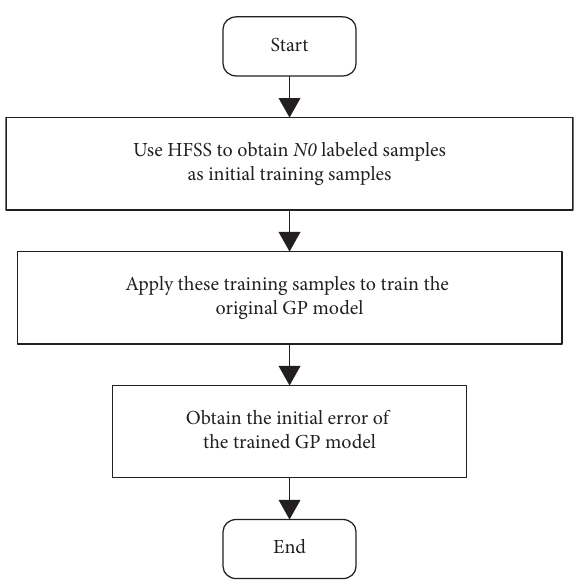
Figure 1: Initial training